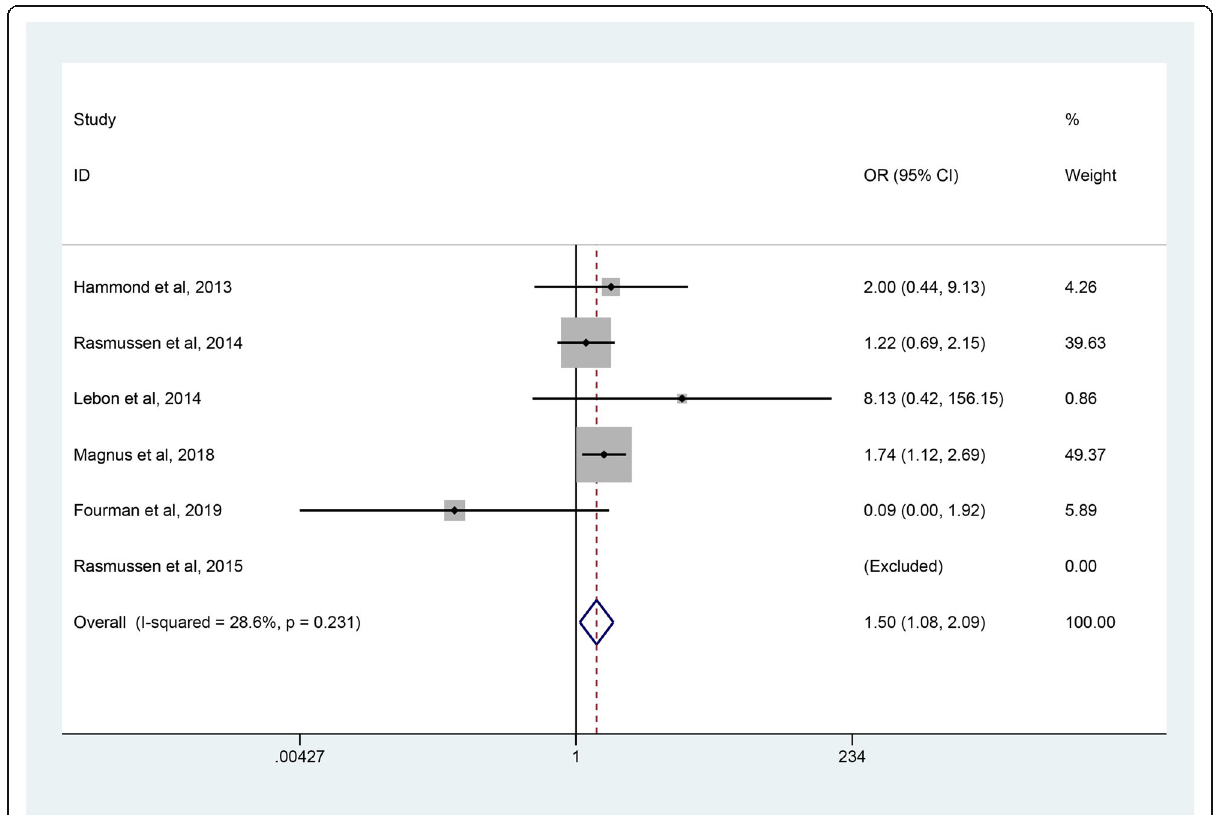
Fig. 11 Forest plot comparing revision rates after resurfacing hemiarthroplasty (RHA) versus stemmed hemiarthroplasty